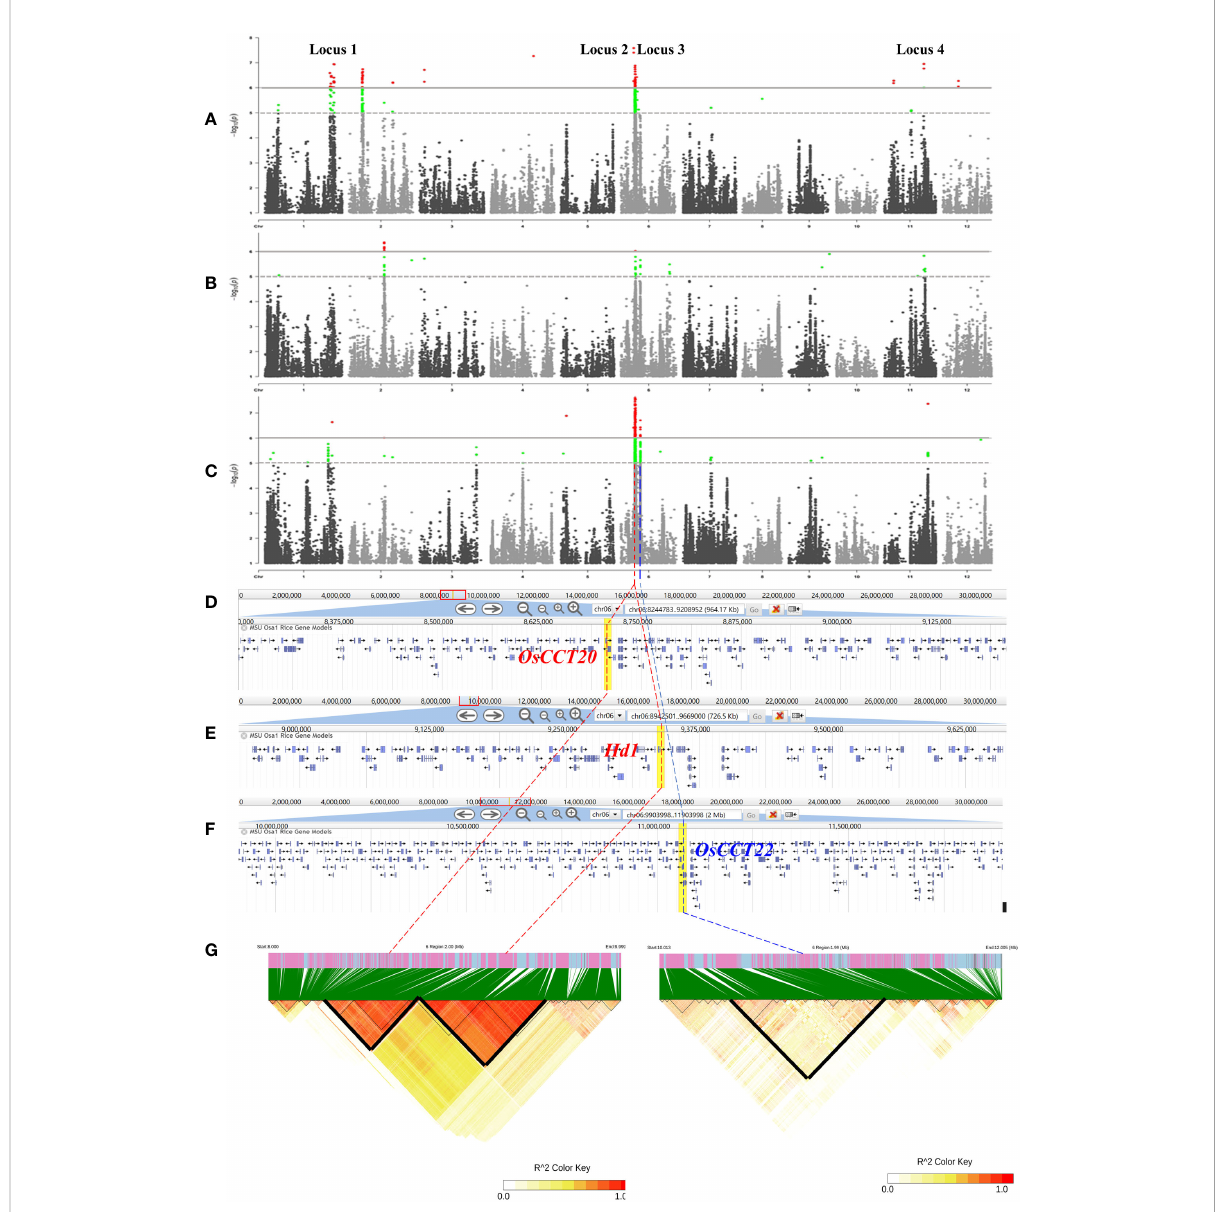
FIGURE 2 Results of the genome-wide association study. (A – C) Manhattan plot of 274 accessions in 2019, 2020, and 2021. Gray lines indicate threshold lines by 10 -5 and 10 -6 ; red and green dots mean SNPs above the threshold line. (D – F) Annotation of genes that are in highly linkage disequilibrium block (G) linkage disequilibrium block analysis of 2MB region surrounding the lead SNPs, highly linkage disequilibrium blocks are displayed in bold